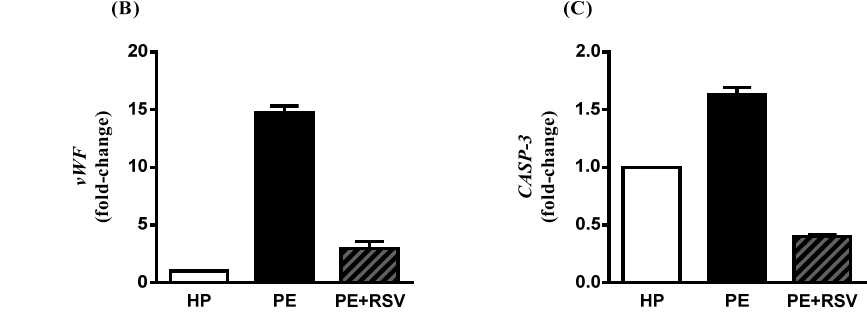
Figure 2. Total ROS fluorescence intensity was measured by DHE ( A , B ) and total antioxidant capacity was assessed by FRAP ( C ). Human umbilical vein endothelial cells (HUVECs) were incubated with 10% ( v / v ) pooled plasma from HP ( n = 10) and PE ( n = 10) ( A ) and then incubated with RSV (10 µ M) for 24 h, Apocynin (100 µ M) and L-NAME (100 µ M) for 30 min before adding the plasma and RSV ( B ) total antioxidant capacity shown in ( C ). Data are presented as mean ± SEM. Comparisons between two groups were performed by the Mann–Whitney test ( A ) Comparisons between three or more groups were performed by one-way ANOVA followed by Tukey’s multiple tests ( B ) and Bonferroni’s multiple tests ( C ). * ( p < 0.05); ** ( p < 0.001); ****( p < 0.0001).